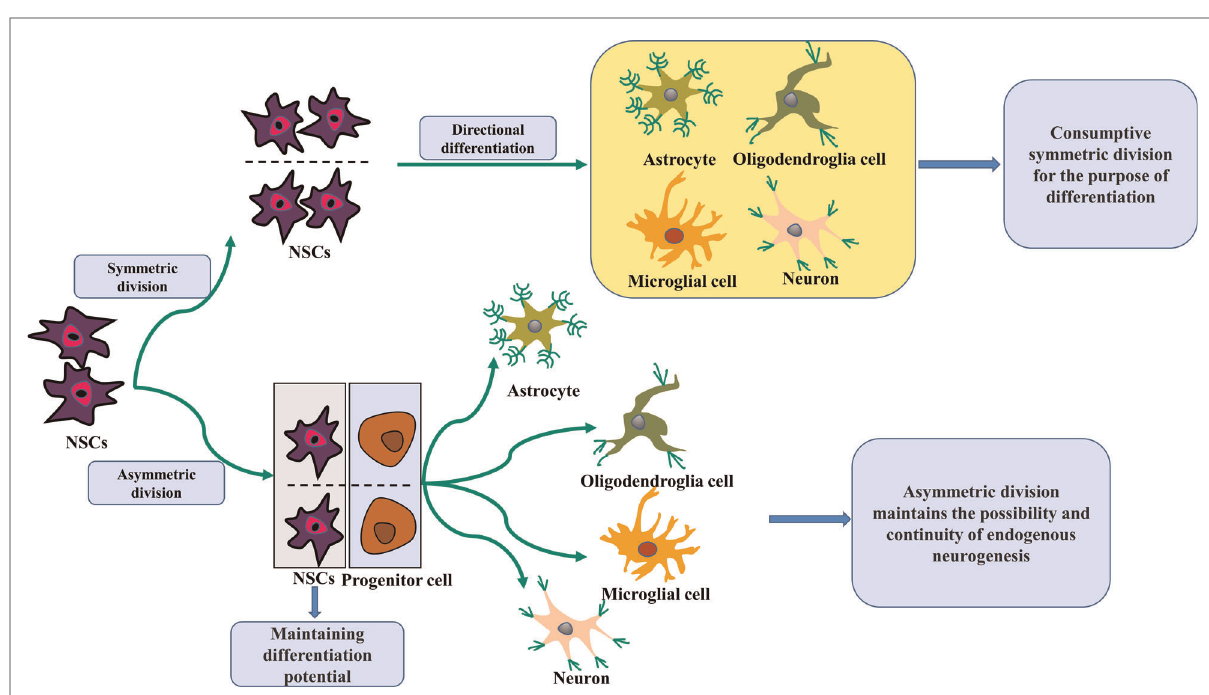
FIGURE 1 Schematic of NSCs division and differentiation. NSCs proliferate and differentiate by symmetrical and asymmetrical division. In the adult brain, they usually undergo symmetric divisions to promote self-proliferation or directed differentiation. Over time, this increasing number of expendable symmetric divisions for differentiation purposes will result in a gradual NSCs reduction, leading to a lack of spontaneous endogenous neurogenic repair capacity after brain injury. In contrast, asymmetric division maintains the possibility and continuity of endogenous neurogenesis because it retains NSCs with differentiation potential. NSCs, neural stem